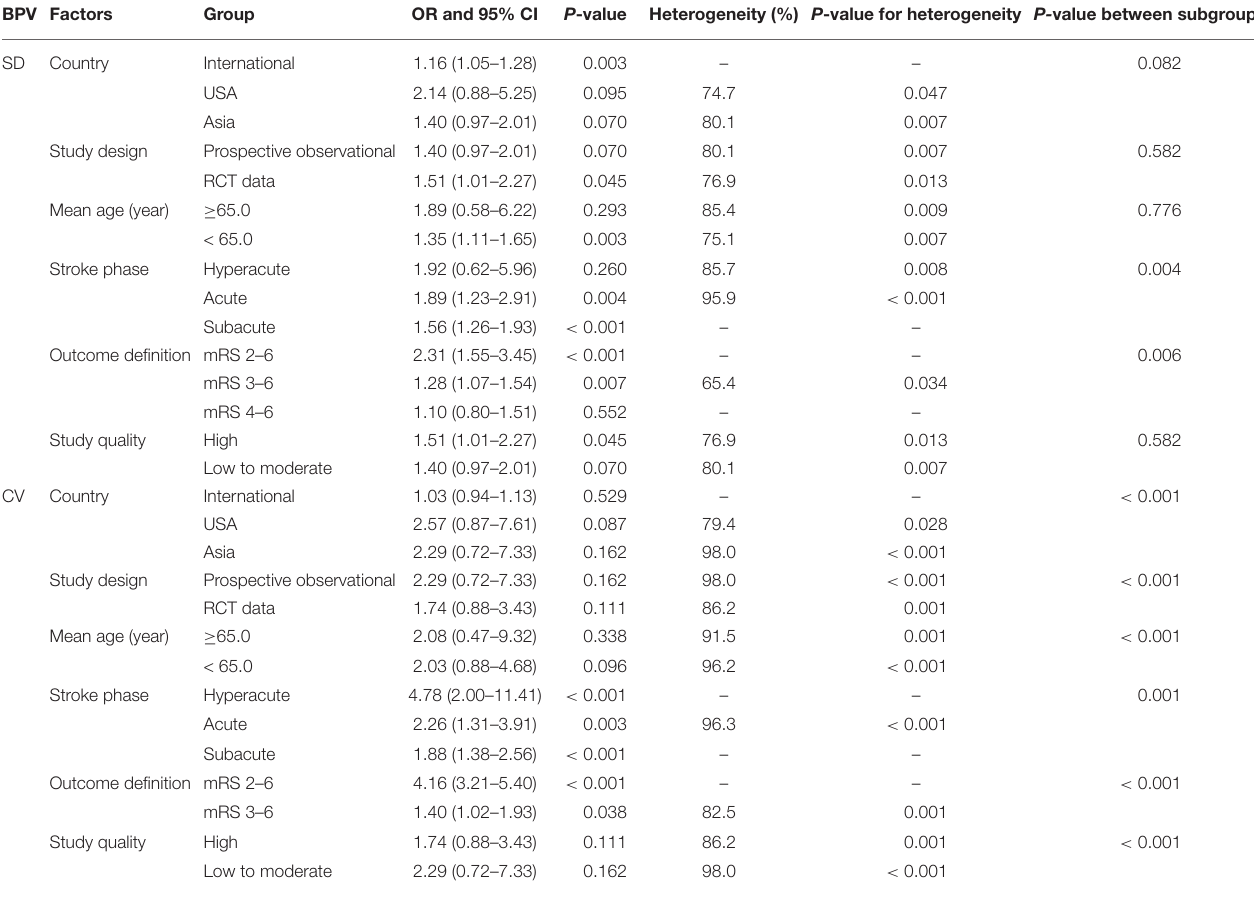
TABLE 3 | Subgroup analyses for the risk of poor